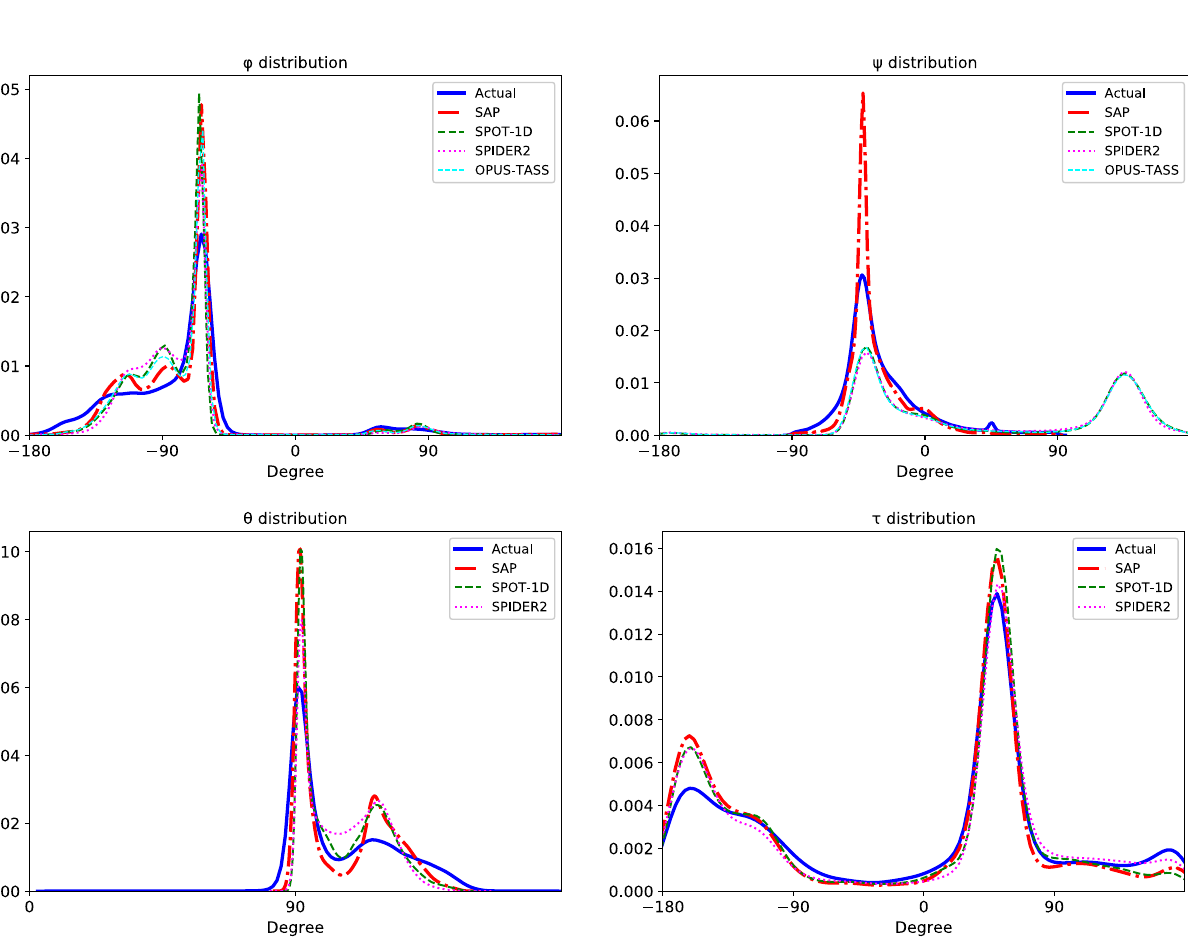
Figure 5. Distributions of actual angles of testing proteins and predictions of SAP, OPUS-TASS, SPOT-1D, and